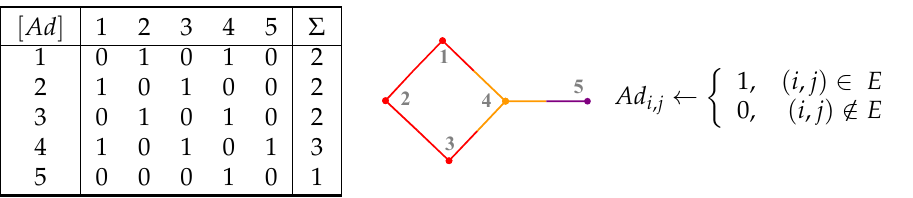
Figure 2. Adjacency matrix on Figure 1. The matrix given in Figure 2 contains an additional column Σ that collects the valences (connections; number of adjacent vertices) for each vertex and it can be used to discriminate the vertices (the vertices are represented with different colors accordingly in Figure 2), being thus a first example of a criterion that can be used to create a vertices partition (for Σ j Ad i , j the partition is in three groups: {1, 2, 3}, {4}, {5}). The distance matrix ( [ Di ] ) contains information about distances (Figure 3). For any two vertices, the corresponding elements in the matrix ( Di i , j ) are set to the value of the distance between them (Algorithm A2 in Appendix B).